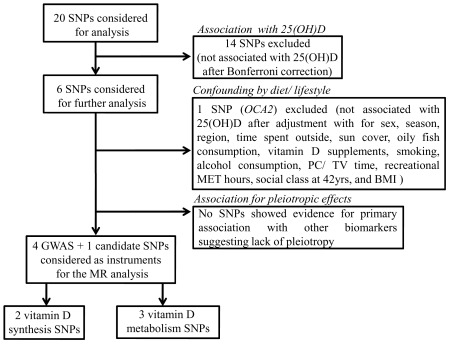
Genetic variation in the vitamin D synthesis and metabolic pathway.Skin exposure to ultraviolet B (UVB) radiation initiates the conversion of 7-dehydrocholesterol to previtamin D3. 7-dehydrocholesterol reductase (DHCR7) encodes the enzyme 7-dehydrocholesterol reductase, which converts 7-dehydrocholesterol to cholesterol, thereby removing the substrate from the synthetic pathway of vitamin D3. The previtamin D3 in turn gets converted to vitamin D3 in a heat-dependent process. Vitamin D (represents D2 or D3) is transported to the liver, where it is converted by vitamin D-25-hydroxylase (CYP2R1) to 25-hydroxyvitamin D [25(OH)D]. This is the major circulating form of vitamin D that is used by clinicians to determine vitamin D status. This form of vitamin D is biologically inactive; it is bound to the vitamin D-binding protein (GC), transported to the kidneys and converted by 25-hydroxyvitamin D-1α- hydroxylase (1-OHase) (CYP27B1) to the biologically active form 1,25-dihydroxyvitamin D3 (Calcitriol). Calcitriol increases the expression of 25-hydroxyvitamin D-24- hydroxylase (24-OHase) (CYP24A1) to catabolise 25(OH)D to the water-soluble, biologically inactive calcitroic acid, which is excreted in the bile. DHCR7 and CYP2R1 function upstream of the production of 25(OH)D and hence, termed as 25(OH)D synthesis indicators, while GC, CYP27B1 and CYP24A1 function downstream of the 25(OH)D production and hence, termed as 25(OH)D metabolism indicators.